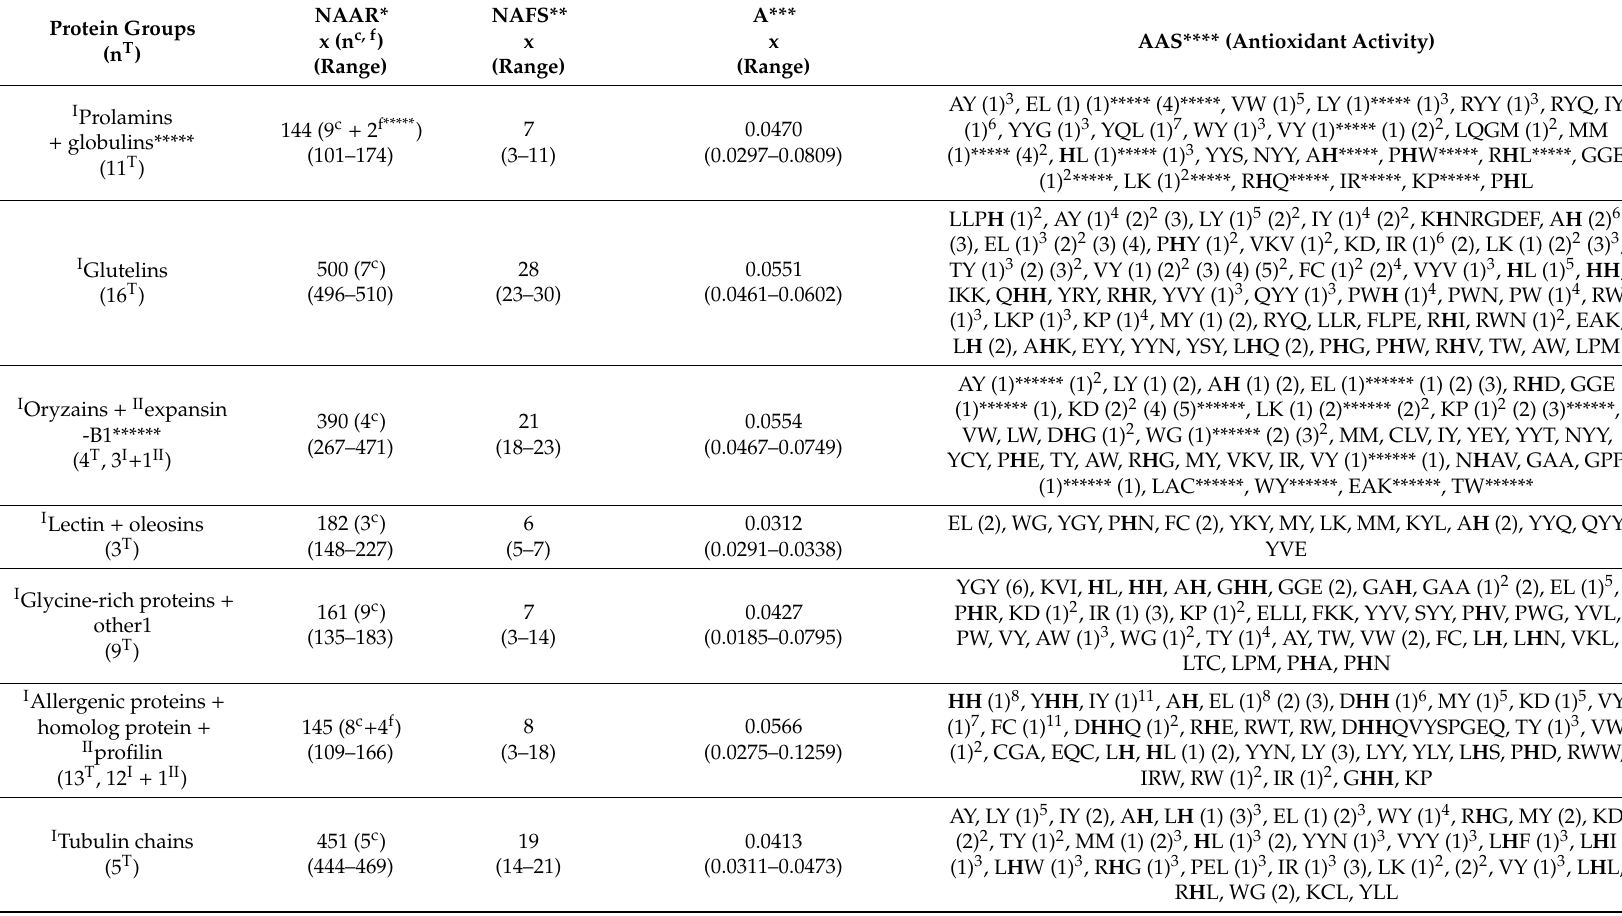
Table 2. Characteristics of rice proteins antioxidant activity ( I Oryza sativa, II Oryza sativa [japonica cultivar-group], III Oryza sativa subsp. japonica